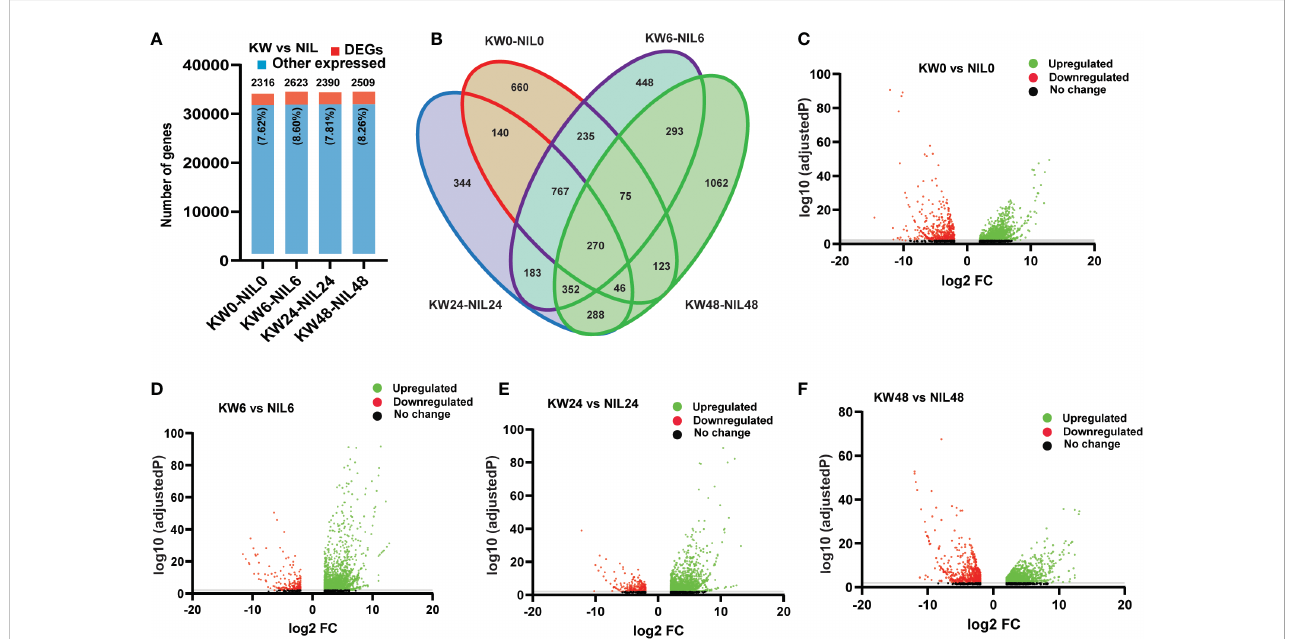
FIGURE 2 Comparison of differentially expressed genes (DEGs) among Kangwenqingzhan (KW) and its NIL under 0h, 6h, 24h, and 48h treatments after BPH feeding. (A) Proportionate percentages of DEGs to other expressed genes between the treatments of KW and NIL, red color in the bar graph shows the proportion of DEGs to other expressed genes illustrated in blue color. (B) Venn diagram depicts unique and overlapped DEGs among different treatments of KW and NIL. (C – F) Volcano plots representing up and downregulated DEGs for different treatments of KW and NIL at 0h, 6h, 24h, and 48h.